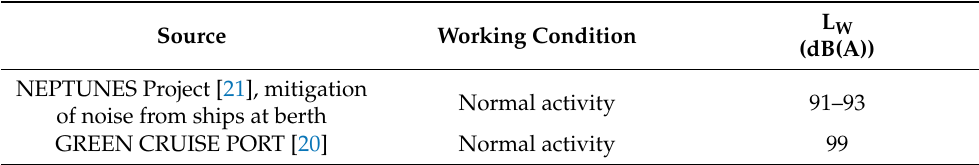
Table 2. Sound power level of reefers, as reported in [20,21].